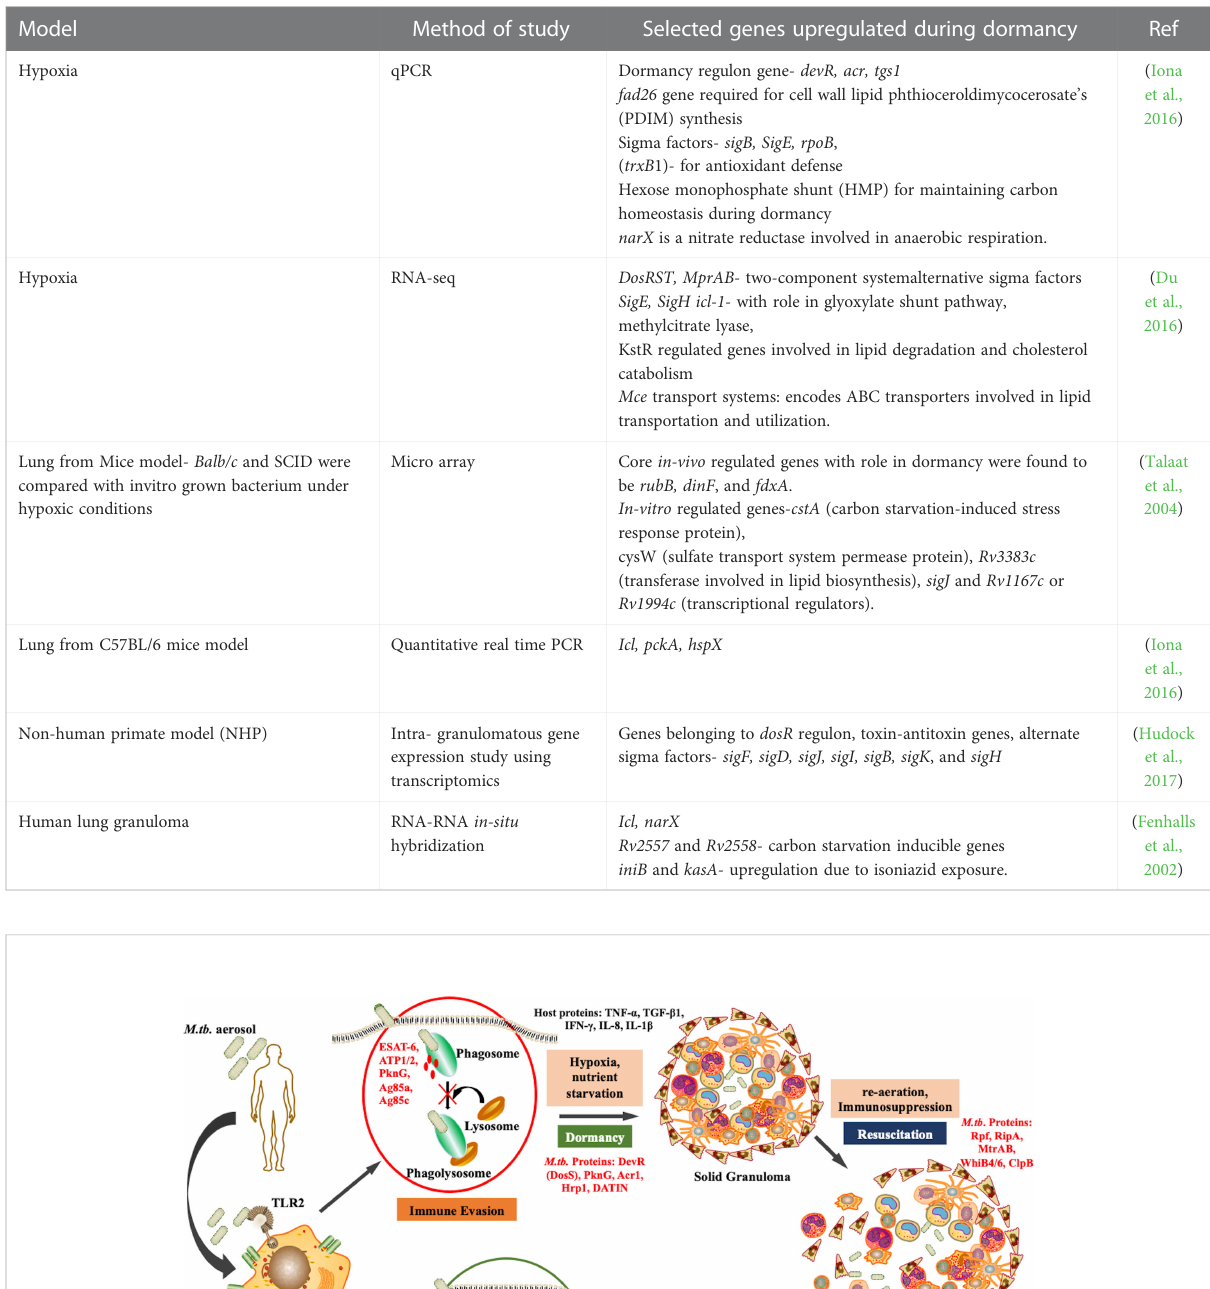
TABLE 1 List of genes upregulated during dormancy in various in-vitro and in-vivo